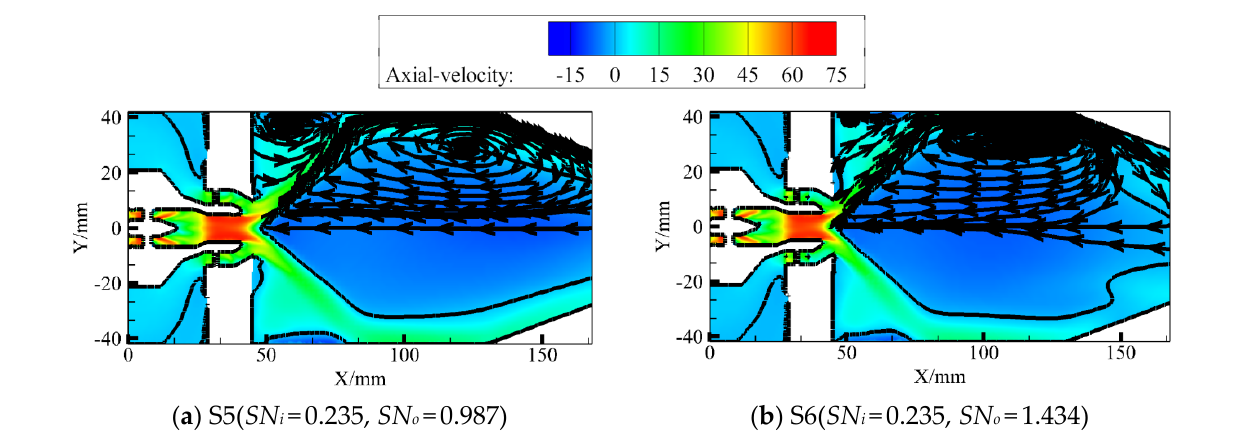
Figure 12. Effect of outer ‐ stage swirl parameters on the flow field.